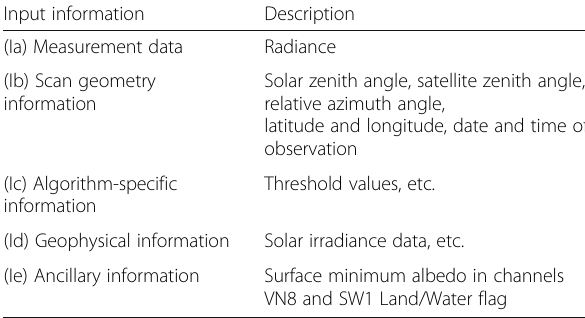
Table 2 Input information for the cloud